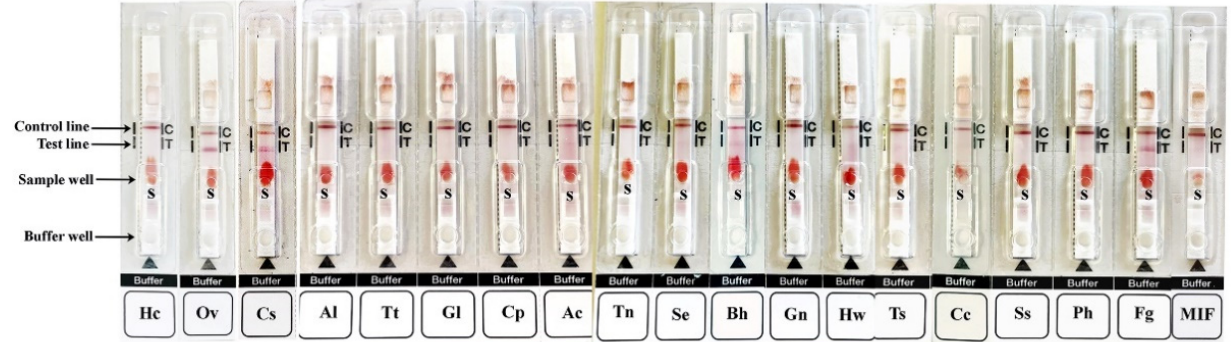
Figure 2. Representative results of the OvB- test kit using stimulated WBS from the healthy control (Hc), opisthorchiasis (Ov), clonorchiasis (Cs), and other parasitic diseases, including: (Al) ascariasis; (Tt) trichuriasis; (Gl) giardiasis; (Cp) capillariasis philippinensis; (Ac) angiostrongyliasis; (Tn) taeniasis saginata; (Se) sparganosis; (Bh) blastocystosis; (Gn) gnathostomiasis; (Hw) hookworm infections; (Ts) trichinosis; (Cc) cysticercosis; (Ss) strongyloidiasis; (Ph) paragonimiasis; (Fg) fascioliasis; and (MIF) minute intestinal fluke infections (lecithodendriid flukes). The intensity of the test line was visually estimated, according to the reference card. (S) indicates sample well. Table 2 . Statistical analysis of the diagnostic values of the kit .